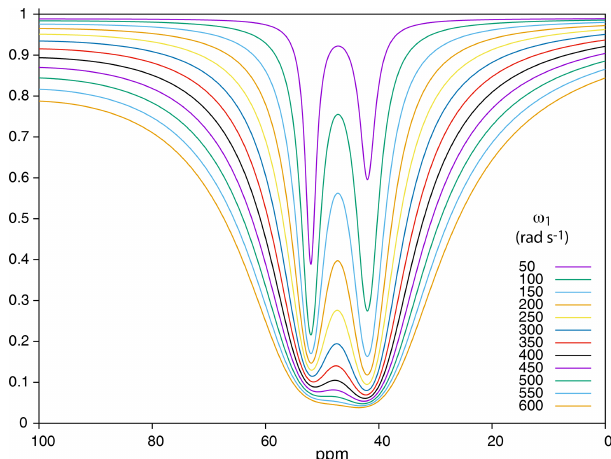
Figure 8. Simulation of 129 Xe Z spectra at 1T for a mixture of two cryptophanes according to the saturation field strength. Conditions for the simulation: see text.